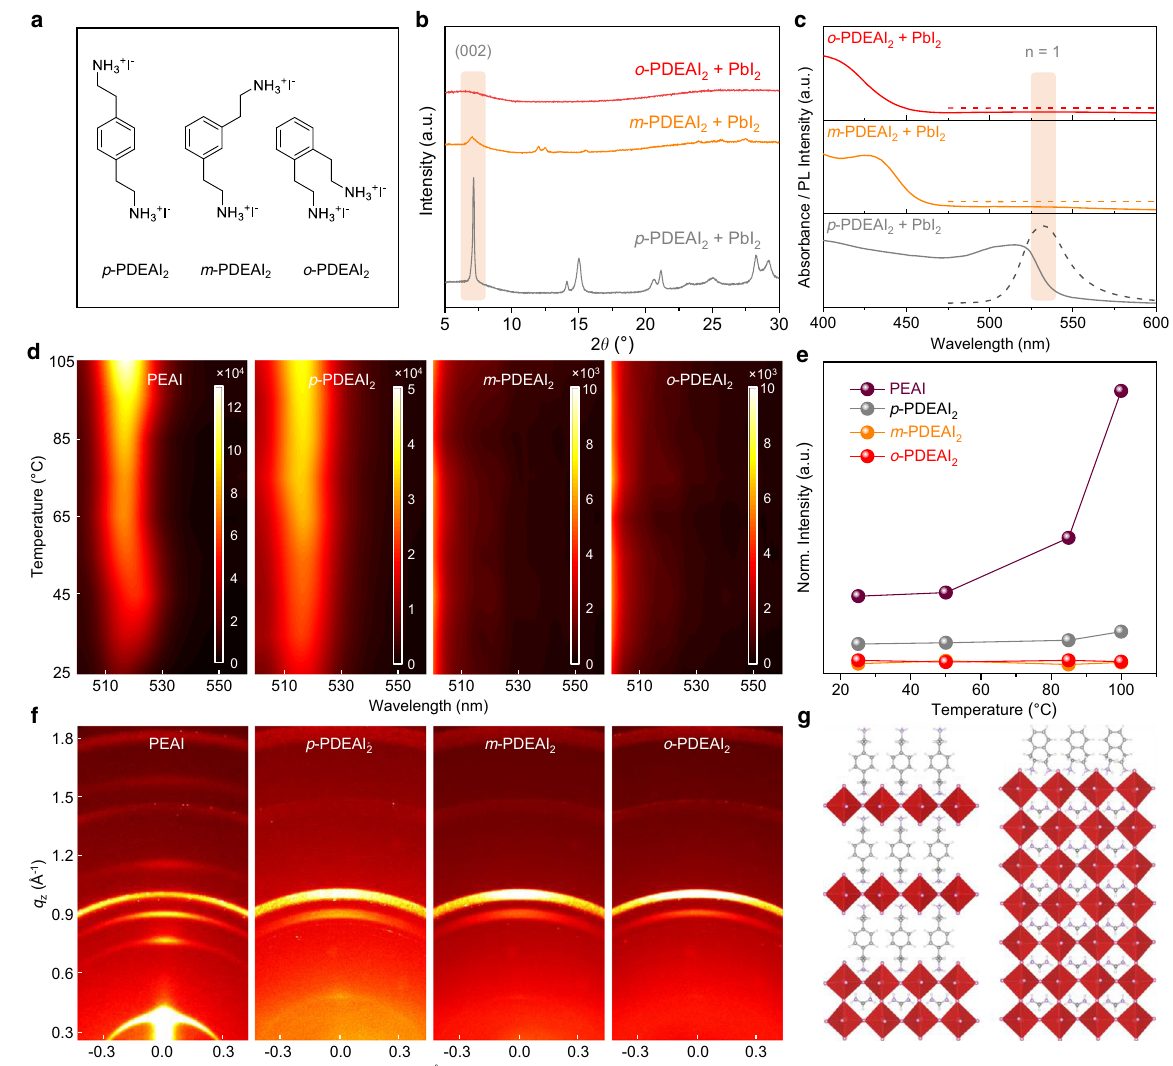
Fig. 1 Structures of PDEAI 2 and subsequent formation of 2D perovskites. a The structures of the PDEAI 2 isomers. b XRD patterns of the fi lms obtained from equimolar ratios of PDEAI 2 and PbI 2 . c Absorption and PL emission spectra of the fi lms obtained from equimolar ratios of PDEAI 2 and PbI 2 . d Temperature-dependent PL images of the perovskite fi lms treated with the different organic halide salts. e Intensity of the (002) re fl ections of the sur fi cial 2D perovskites as a function of annealing temperature for the post-treated perovskite fi lms. f GIWAXS images of the perovskite fi lms following post-treatment. g Schematic illustration of p -PDEAI 2 and o -PDEAI 2 -assembled perovskite